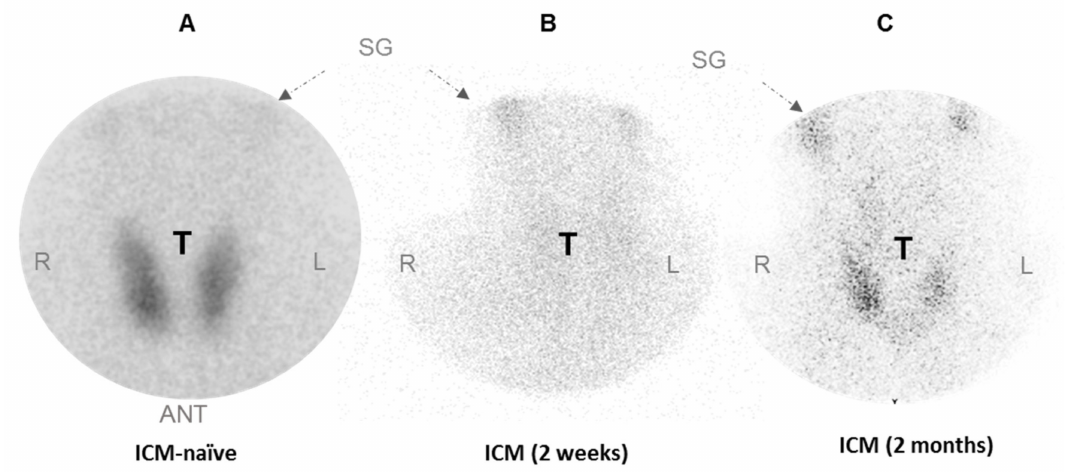
Figure 1. E ff ect of Iomeron on uptake of 99m TcO 4 − by human thyroid. Scintiscans (where the pinhole collimator is centered on thyroids) of ICM-naïve patient ( A ) and patient given Iomeron 2 weeks ( B ) or 2 months before scintigraphy ( C ) are shown. ANT = anterior; SG = salivary glands; T = thyroid, L = left, R =